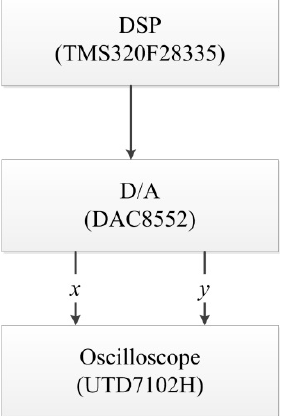
Figure 14. Flowchart of DSP implementation.